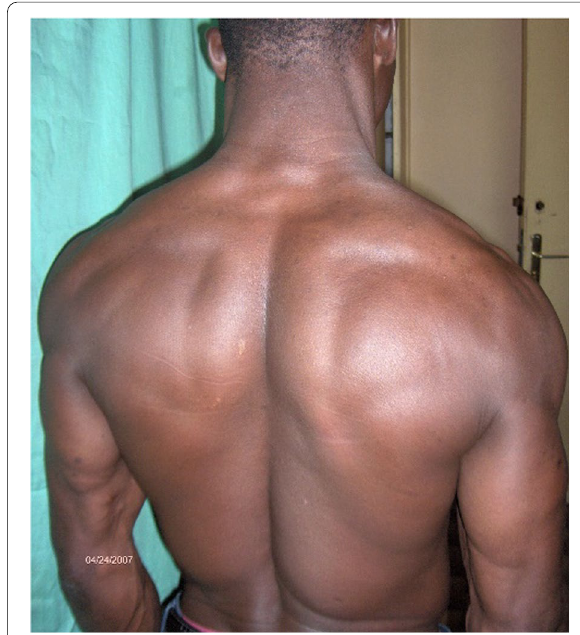
Fig. 3 Neck, arms and back muscular hypertrophy